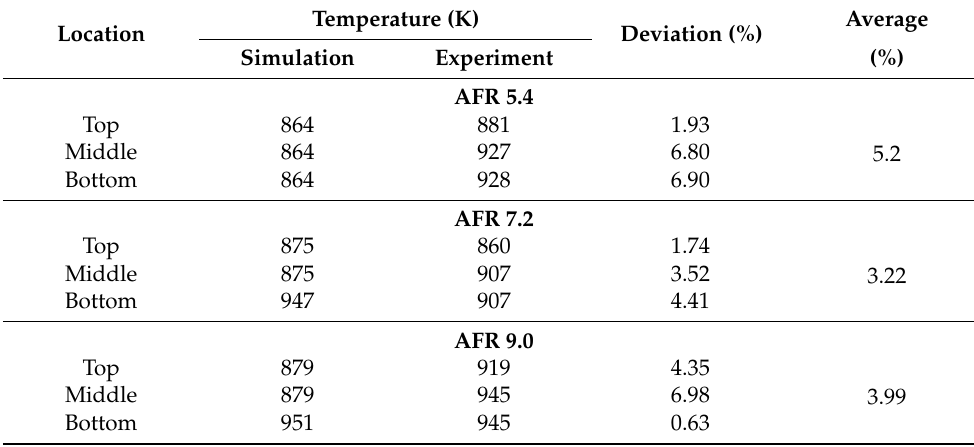
Table 3. Temperature comparison between experiments with numerical